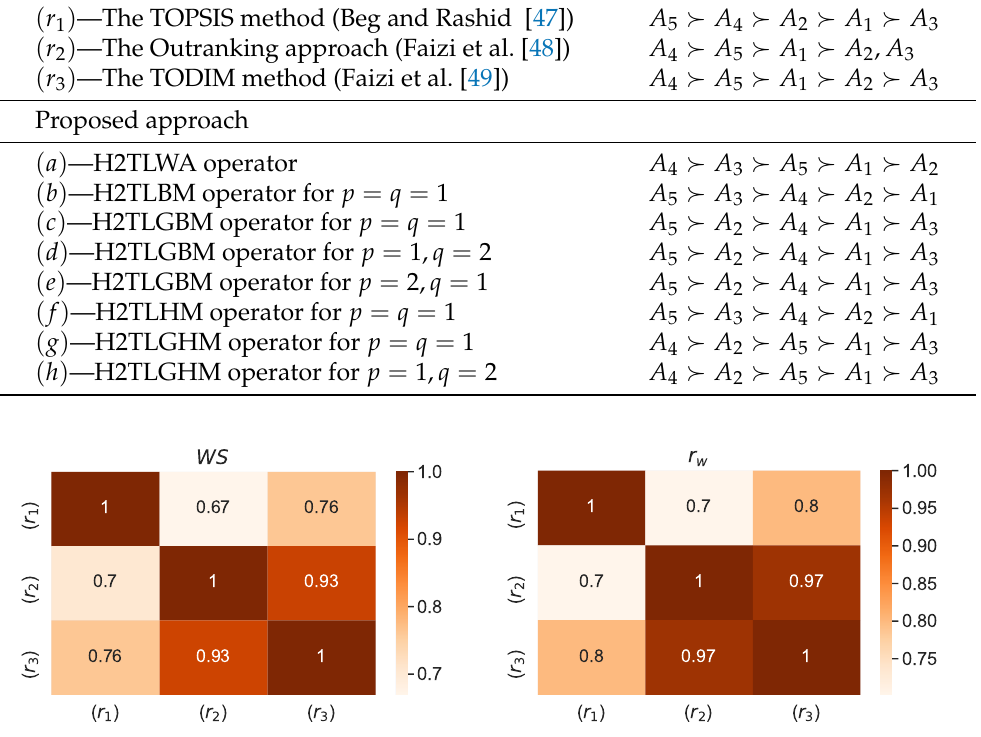
Figure 2. Comparison of r w and WS similarity coefficients [55] for reference rankings ( r 1 ) – ( r 3 )